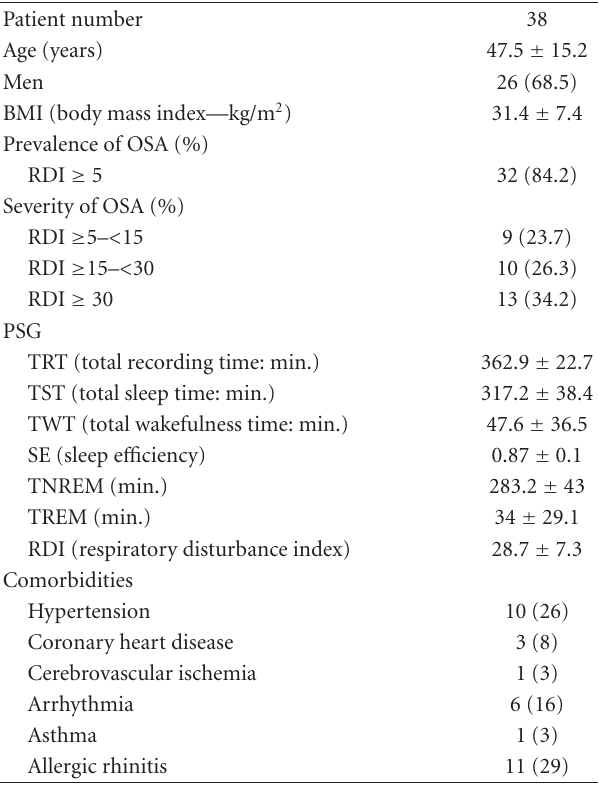
Table 2: Patient characteristics.